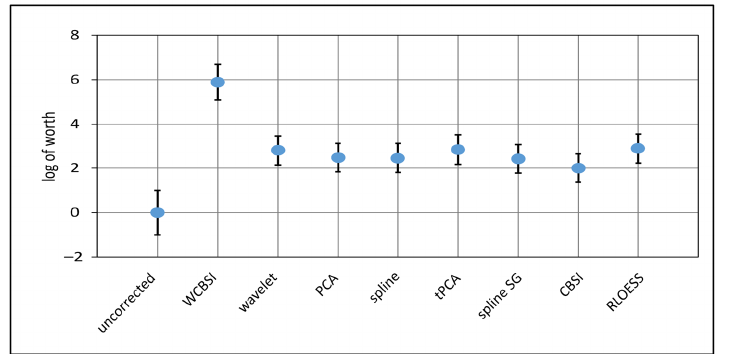
Figure 10. The log worth of the different MA correction methods obtained by fitting a Plackett–Luce model to the ranking data. Higher values indicate better performance of the correction algorithm. WCBSI has the highest worth and “uncorrected” the lowest. All other correction algorithms have similar worths varying around the mean. All worths are referenced to “uncorrected”, for which the mean was set to zero. Error bars indicate standard errors of the mean.